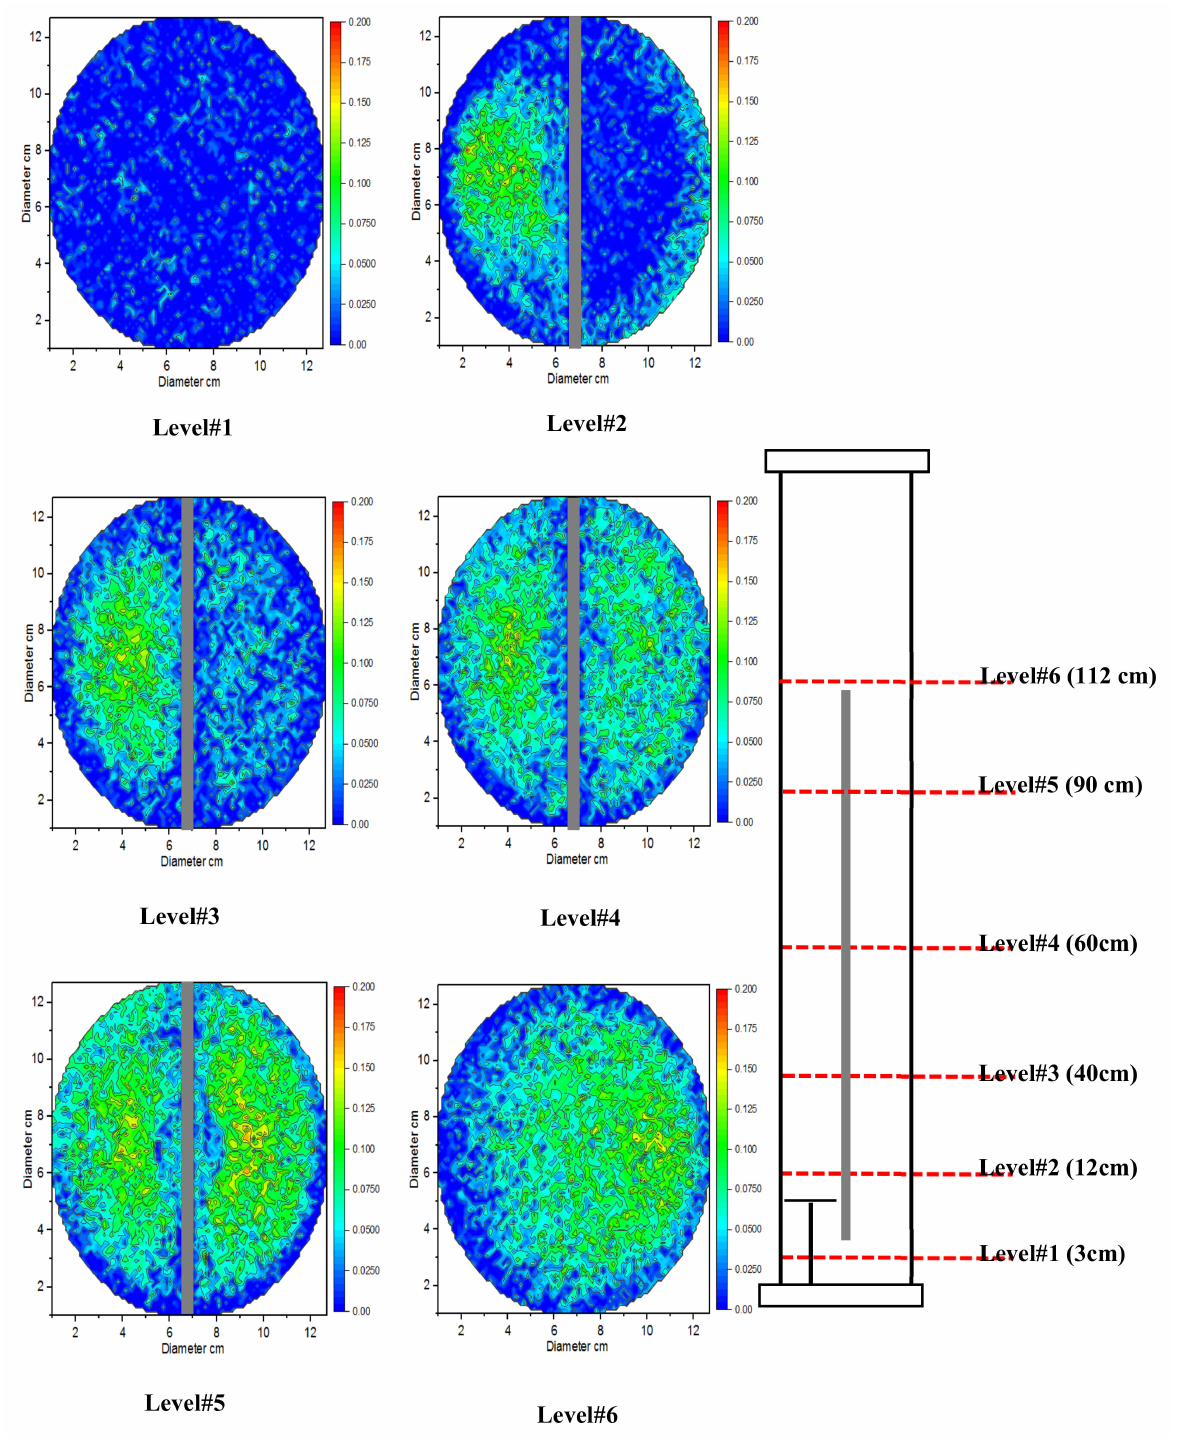
Figure 10. Cross-sectional distributions in gas holdup at different heights of split airlift reactor operated under gas velocity of 3